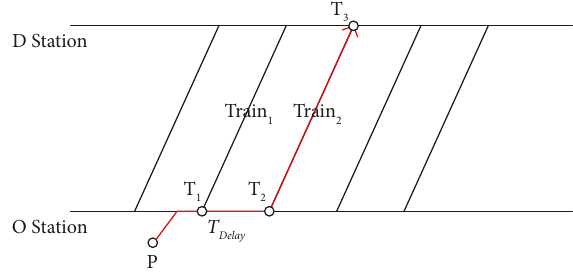
Figure 4: Schematic of a passenger being